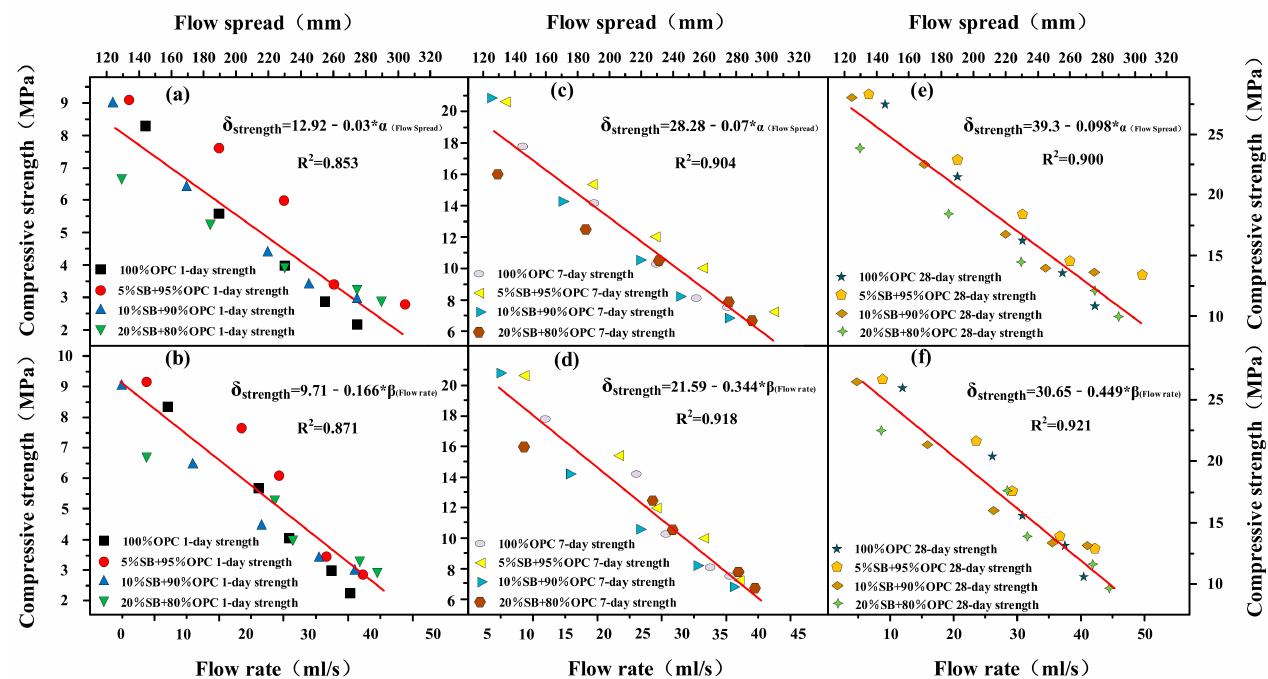
Figure 11. Flow rate and flow spread versus 1 day ( a , b ), 7 days ( c , d ), and 28 days ( e , f ) of compressive strength.